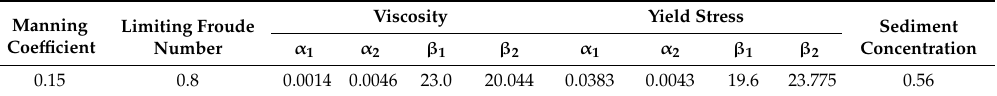
Input parameters of debris flow simulation ( α 1 , β 1 : Chuncheon-shi area, α 2 , β 2 : Cheongju-shi